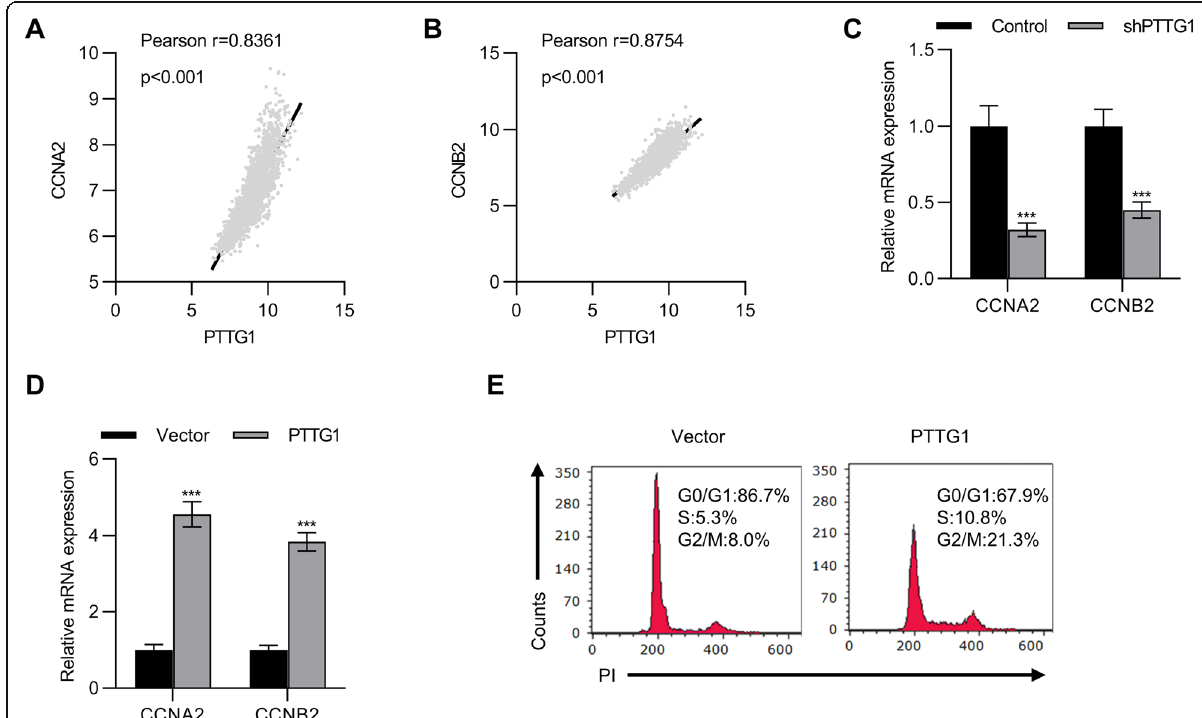
Fig. 5 PTTG1 regulated the expressions of CCNA2 and CCNB2 in the breast cancer cells. a-b TCGA breast cancer dataset was used to explore the correlation between PTTG1 and genes including CCNA2 and CCNB2. c-d qPCR was employed to determine the mRNA levels of CCNA2 and CCNB2 in the PTTG1-knockdown and -overexpression cells. n = 3. e PI staining was performed and flow cytometry was used to analyze the effects of PPTG1 on the cell cycle. Data were represented as mean ± S.D. *** P <